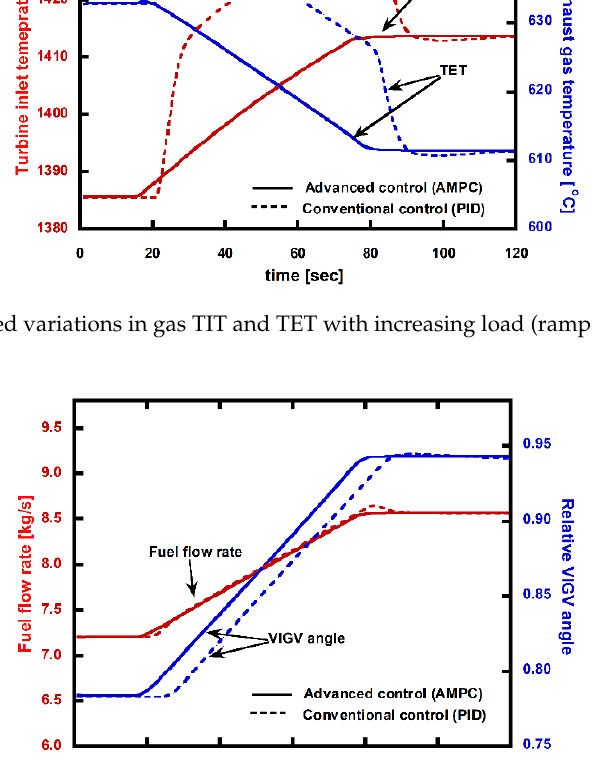
Figure 18. Simulated variations in gas TIT and TET with increasing load (ramp rate: 30 MW/min).